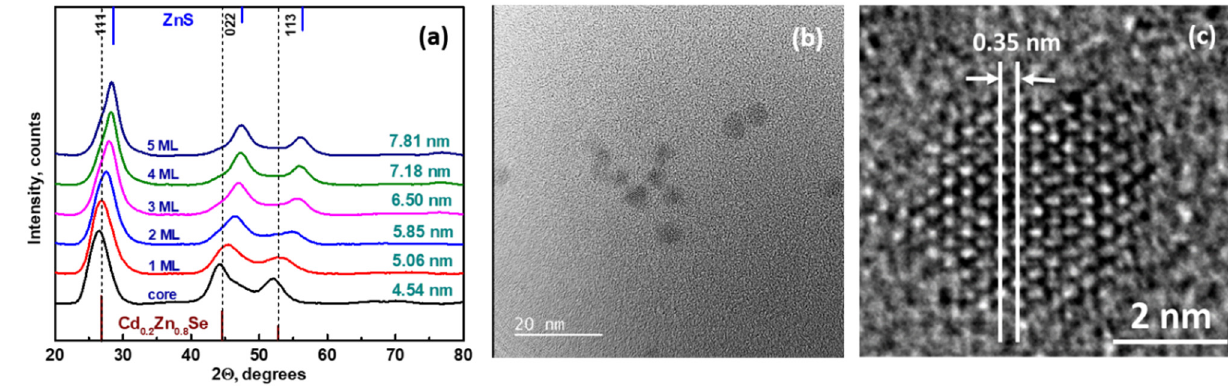
Figure 2. XRD patterns of Cd 0 . 25 Zn 0 . 75 Se/ZnS QDs with different shell thicknesses ( a ), TEM ( b ), and HRTEM ( c ) images of Cd 0 . 25 Zn 0 . 75 Se (core).